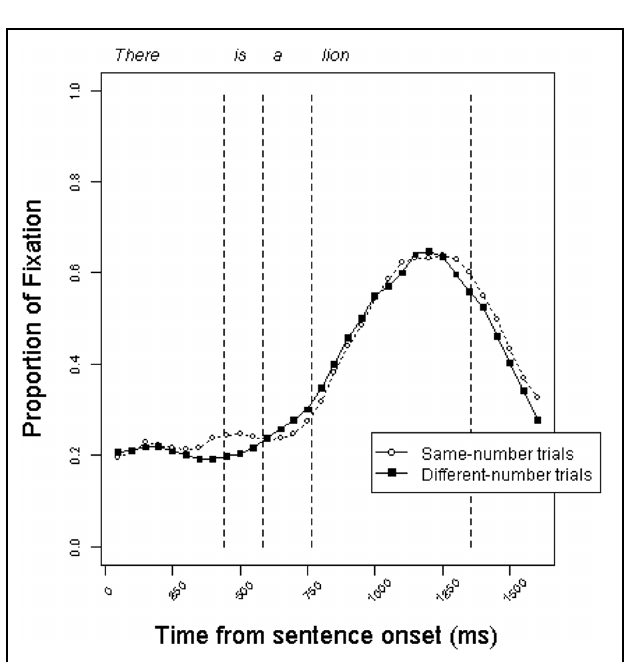
FIGURE 5 | Proportion of fixations to target objects in the indefinite condition on same-number vs. different-number trials in Experiment